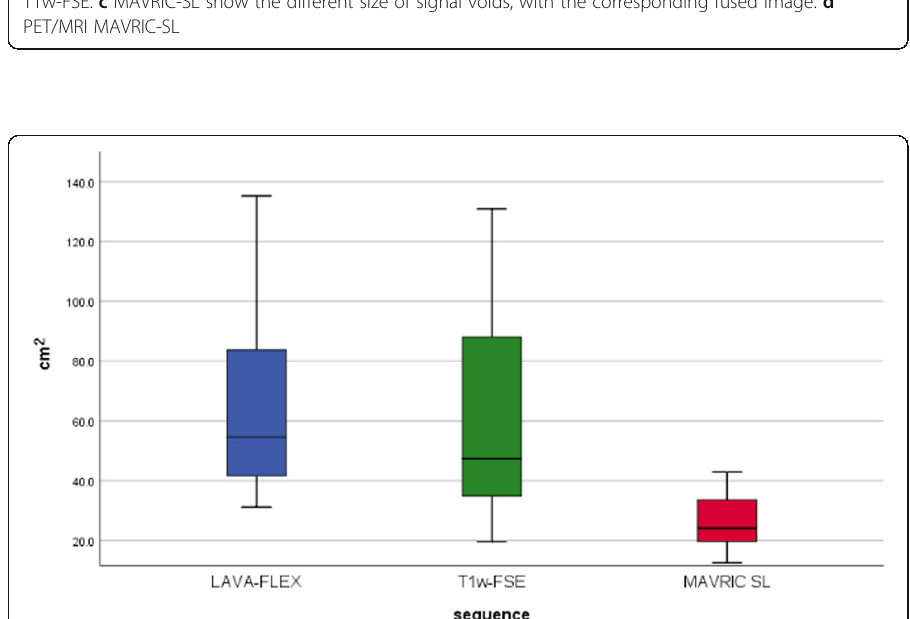
Fig. 2 Box plot illustrating the size of signal void (in cm 2 ) in the tested